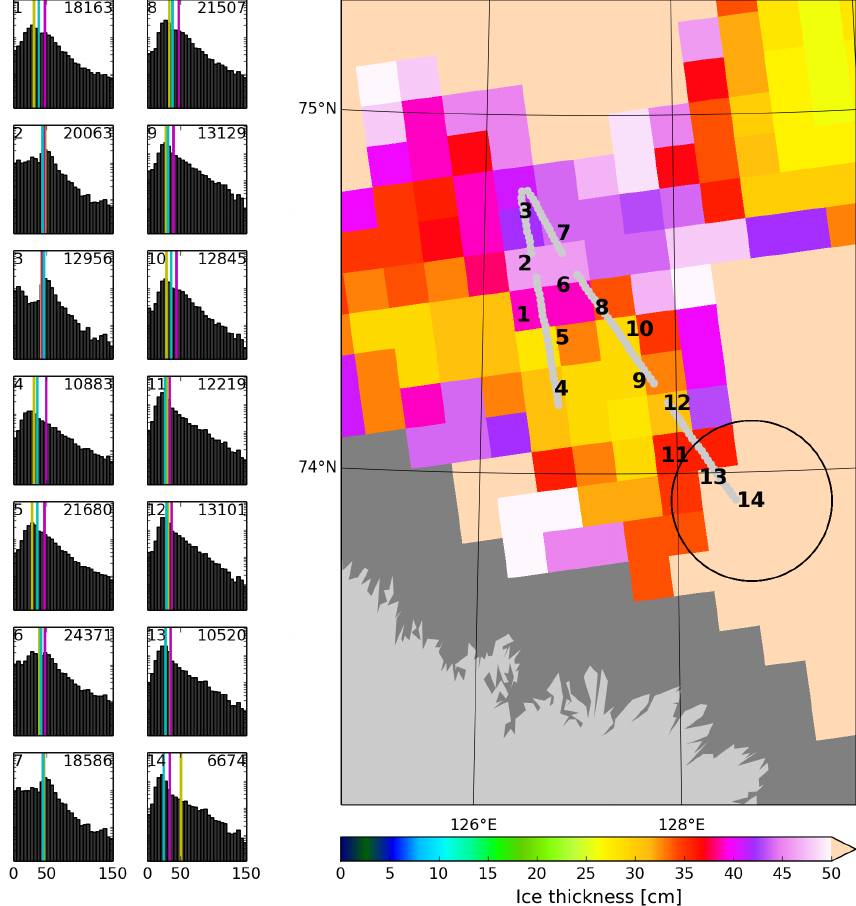
Fig. 8. Comparison of EM bird and SMOS SIT. (right) Location of EM bird flight of 20 April 2012 (grey track) over SMOS retrieved SIT in NSIDC 12.5km grid (coloured background tiles). The numbers along the flight track indicate the native SMOS 15km ISEA grid points. The large black circle illustrates the average size of a SMOS footprint. (left) Histograms of EM bird SIT retrievals within circular regions of SMOS footprint size centered around the same number (upper left of each histogram) in the right-hand image. The number of EM bird measurements for each histogram is shown in the upper right. The coloured vertical lines correspond to the mean (purple) and median (cyan) of the EM bird measurements while yellow lines indicate the retrieved SIT by SMOS.